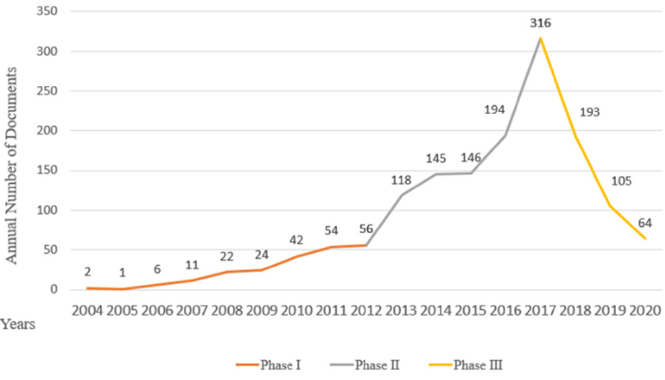
Figure 1. Annual number of documents.